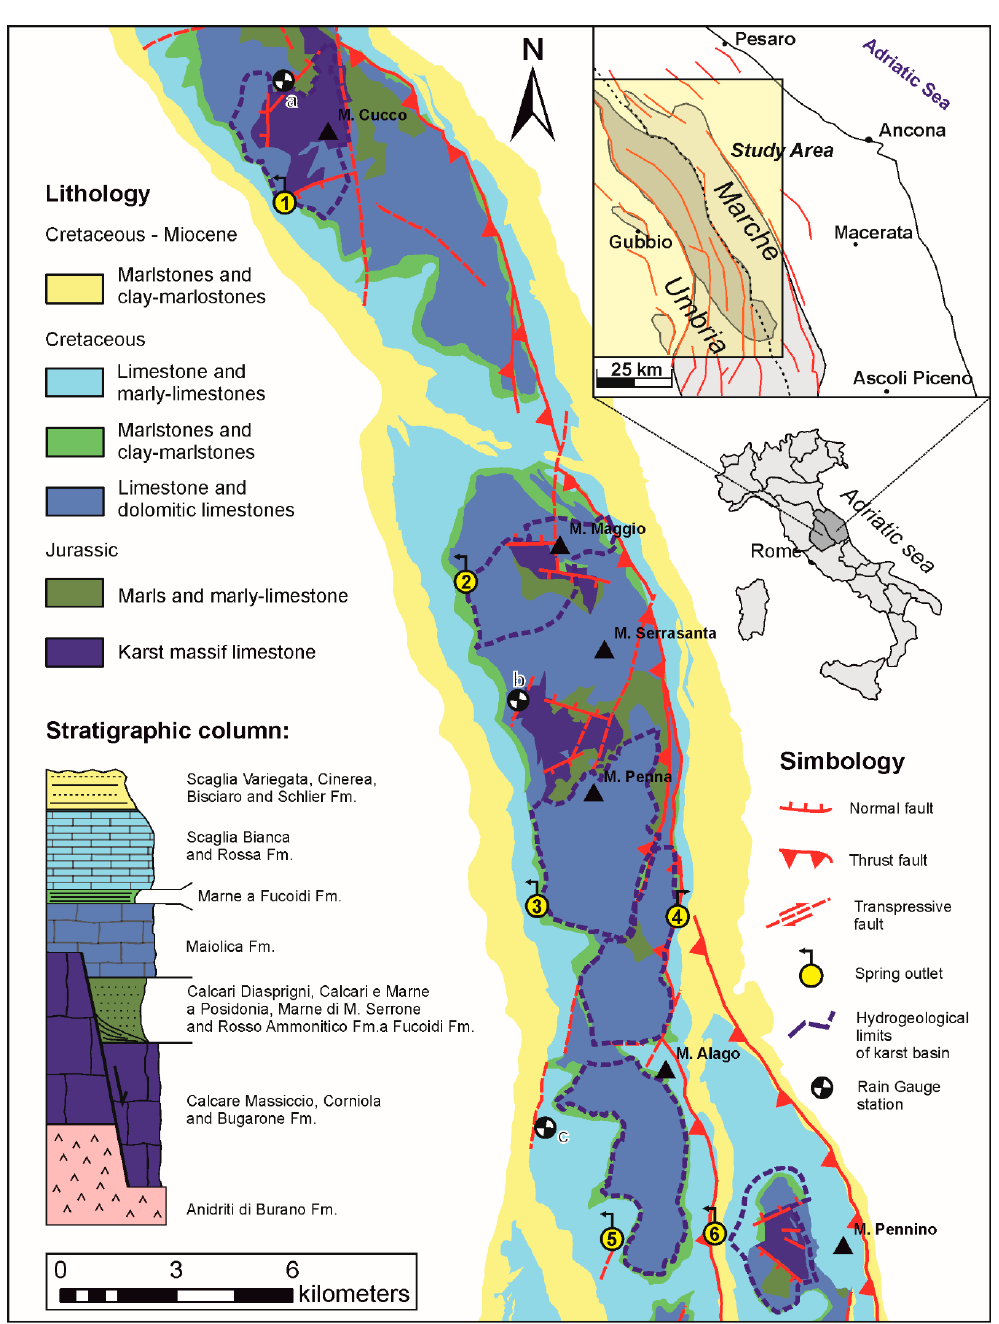
Figure 1. Simplified hydrogeological map of the study area at a regional scale (Northern Apennines), illustrating different geological and hydrogeological elements: a partial stratigraphic column of the Umbria-Marche stratigraphic succession spanning the Upper Triassic to the Upper Miocene; the locations of the studied aquifer springs: (1) Scirca spring, (2) Vaccara spring, (3) Boschetto spring, (4) Capo d’acqua spring, (5) San Giovenale spring, and (6) Bagnara spring; the hydrogeological recharge area boundaries; the locations of the rain gauge stations used: (a) Mt Cucco station, (b) Gualdo Tadino station, and (c) Nocera Umbra